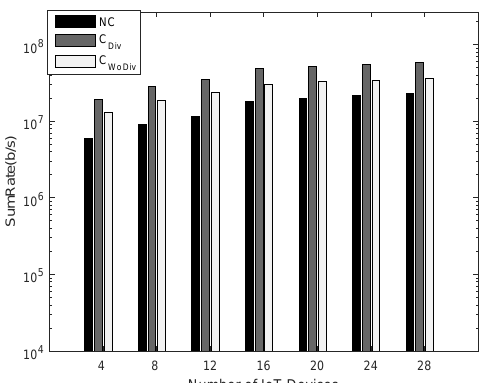
Figure 4. Sum-rate with respect to different number of total devices, with two relays and minimum device data rate of 128 kbps.